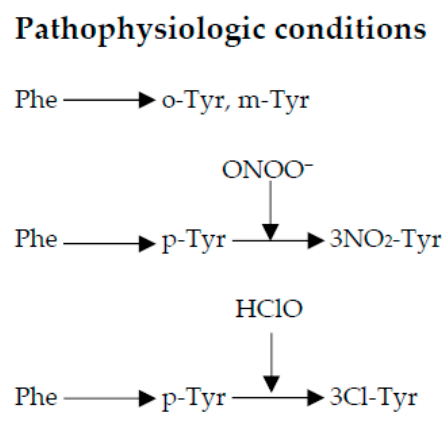
Figure 2. Under physiological conditions, phenylalanine (Phe) is enzymatically oxidized to para- tyrosine (p-Tyr) by the action of phenylalanine hydroxylase. Under pathophysiological conditions, Phe is oxidized by ferryl species and peroxidases into ortho-tyrosine (o-tyr) and meta-tyrosine (m- tyr), and p-Tyr by peroxynitrite (ONOO − ) into 3-nitrotyrosine (3NO 2 -Tyr) or by hypochlorous acid (HClO) into 3-chlorotyrosine